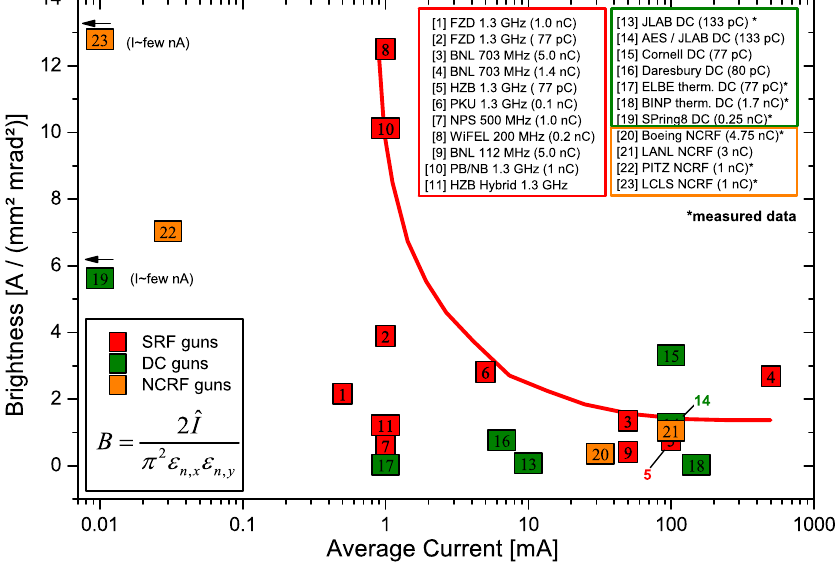
FIG. 18. Comparison of some electron sources by plotting bunch brightness versus average current. The colored squares are representing the three types of guns. An anticipated trend for SRF guns is shown by the red